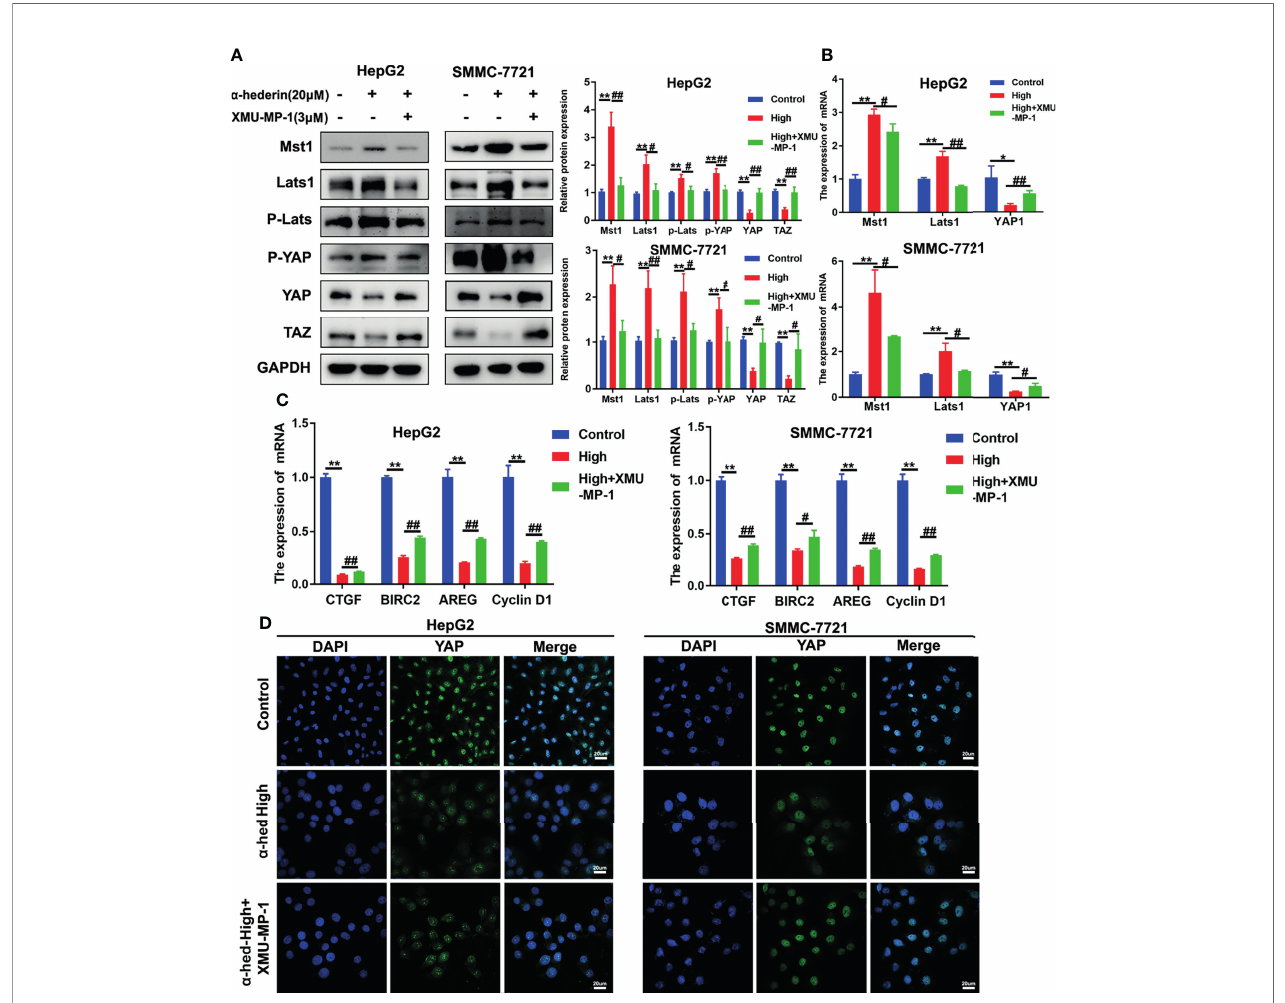
FIGURE 5 | a -hederin-induced Mst1 upregulation was responsible to the inhibition of YAP signaling pathway. (A) The expression of proteins involved in Hippo-YAP signaling pathway in HepG2 and SMMC-7721 cells that treated with a -hederin or a -hederin/XMU-MP-1 was analyzed by Western blot. (B) The expression of Hippo- YAP signaling target genes in HepG2 and SMMC-7721 cells that treated with a -hederin or a -hederin/XMU-MP-1 was analyzed by RT-qPCR. (C) Analysis of genes associated with cell proliferation andapoptosis in HepG2 andSMMC-7721 cells treated with a -hederin or a -hederin/XMU-MP-1. (D) Representative immuno fl uorescence images of YAP inHepG2 andSMMC-7721 cells with the indicated treatment. Signi fi cance: * p < 0.05 versus control,** p < 0.01 versuscontrol, # p < 0.05 versusHigh concentration, ## p < 0.01 versusHigh